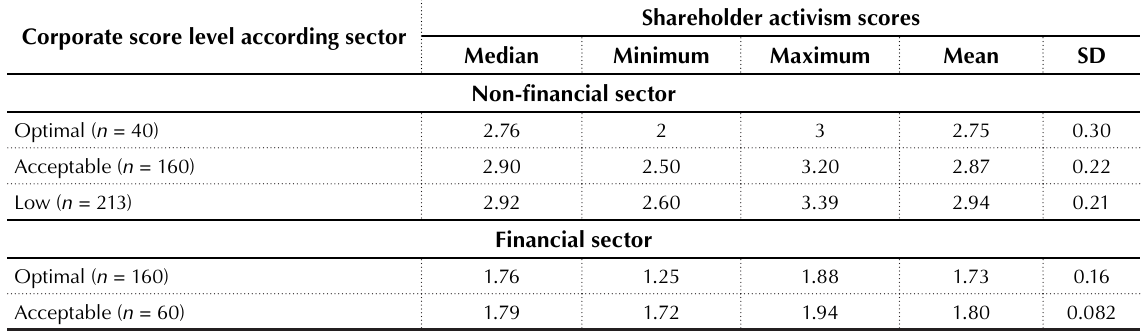
Table 4. Distribution of shareholder activism scores for the listed companies according to their corporate governance score